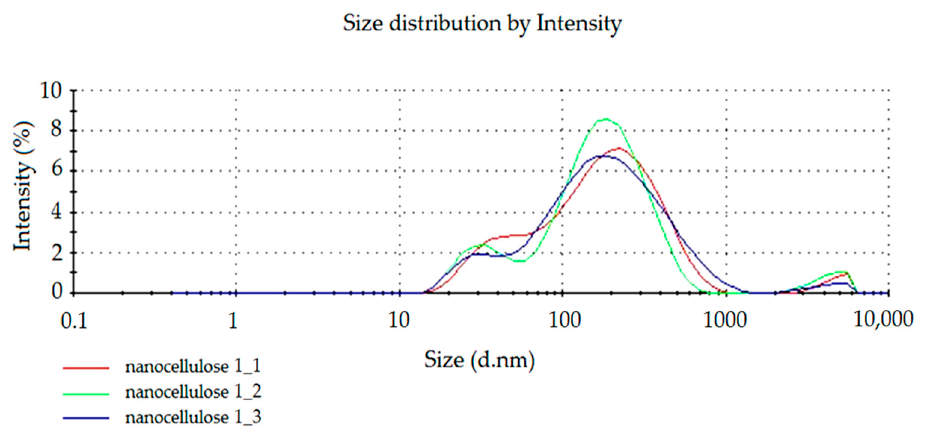
Figure 1. The spectrum of dependence of particle intensity on particle size.